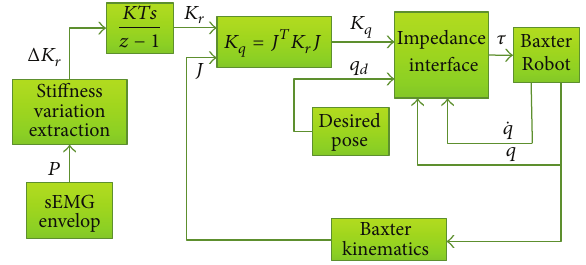
Figure 6: Stiffness variation mapping from human to robot with variable impedance